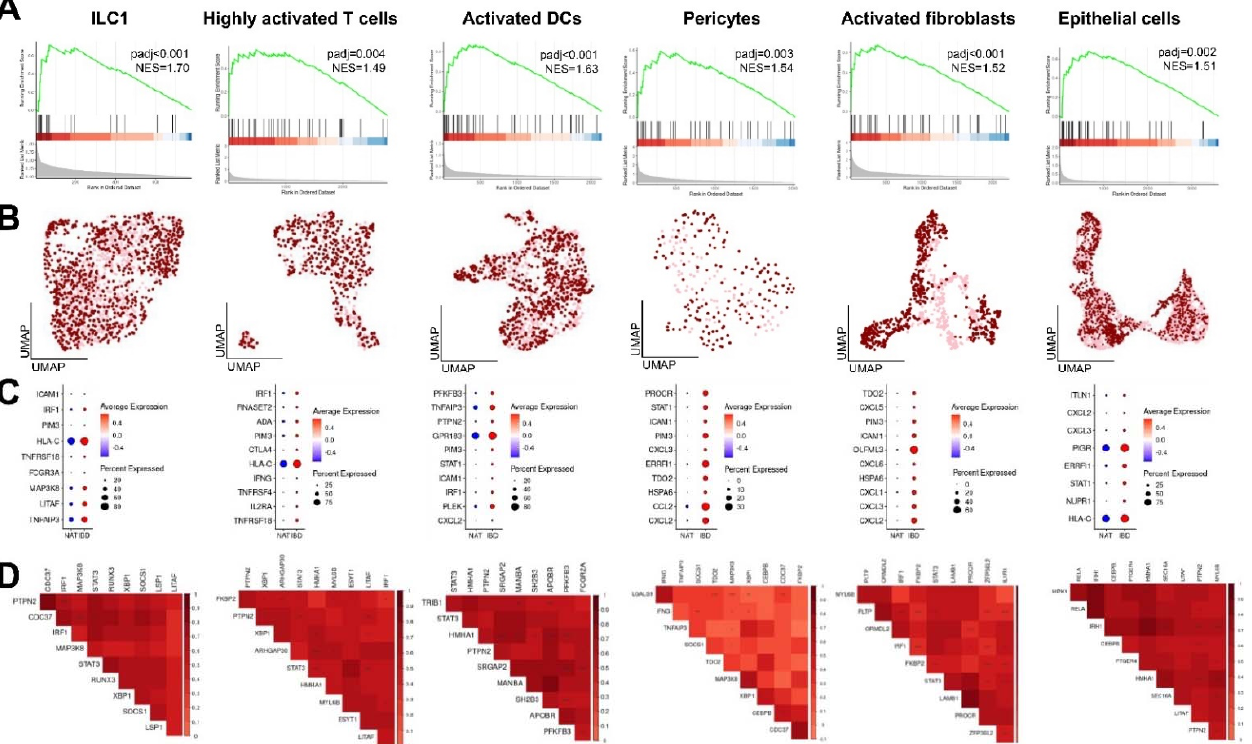
Figure 2. Cell type ‐ specific upregulation and co ‐ expression of risk genes in CD lesions. ( A ) GSEA confirms the enrichment of CD ‐ induced genes in ILC1, highly activated T cells and dendritic cells, pericytes and activated fibroblasts, as well as epithelial cells, isolated from inflamed CD lesions. ( B ) UMAPs displaying similarities between control (light pink) and inflamed (dark red) cells based on dimensional reduction. While gene expression patterns among those conditions appear comparable, inflamed activated fibroblasts are highly distinct from controls. ( C ) Dot plots displaying ten genes per cell type with the most significant differential expression. Dot size indicates the percentage of cells expressing the respective genes, dot color represents expression intensity. ( D ) Correlation plots revealing co ‐ expression patterns of CD ‐ induced genes.